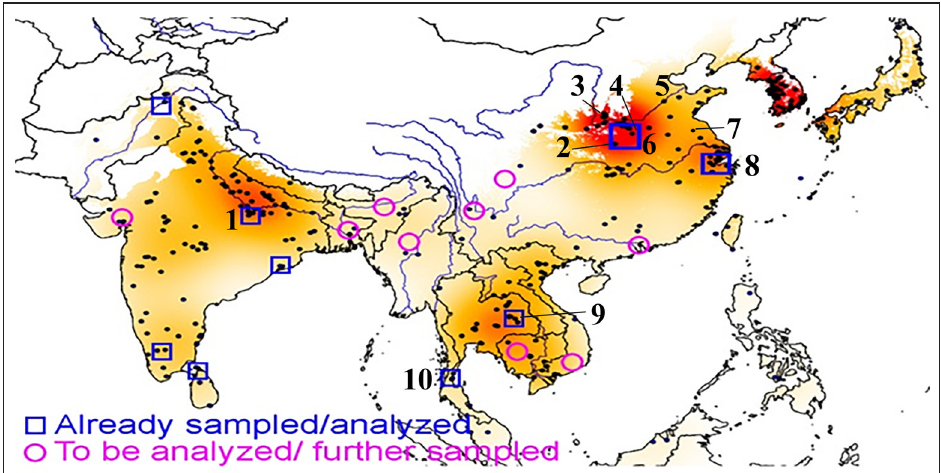
Figure 1: Heat map showing regions with more archaeobotanical evidence for rice, for all periods (the more data, the darker the red). Selected sites/site groups numbered: 1. Mahagara and Koldihwa, 2. Baligang, 3. Sushui valley, 4. Chengyao, 5. Houli culture area, 6. Jiahu. 7. Shushanji, 8. Lower Yangtze region (Kuahuqiao, Tianluoshan, Majiabang, Caoxieshan, Xiaodouli, Maoshan, Liangzhu), 9. Ban Non Wat and Non Ban Jak, 10. Khao Sam Kaeo (Heat map prepared by F.